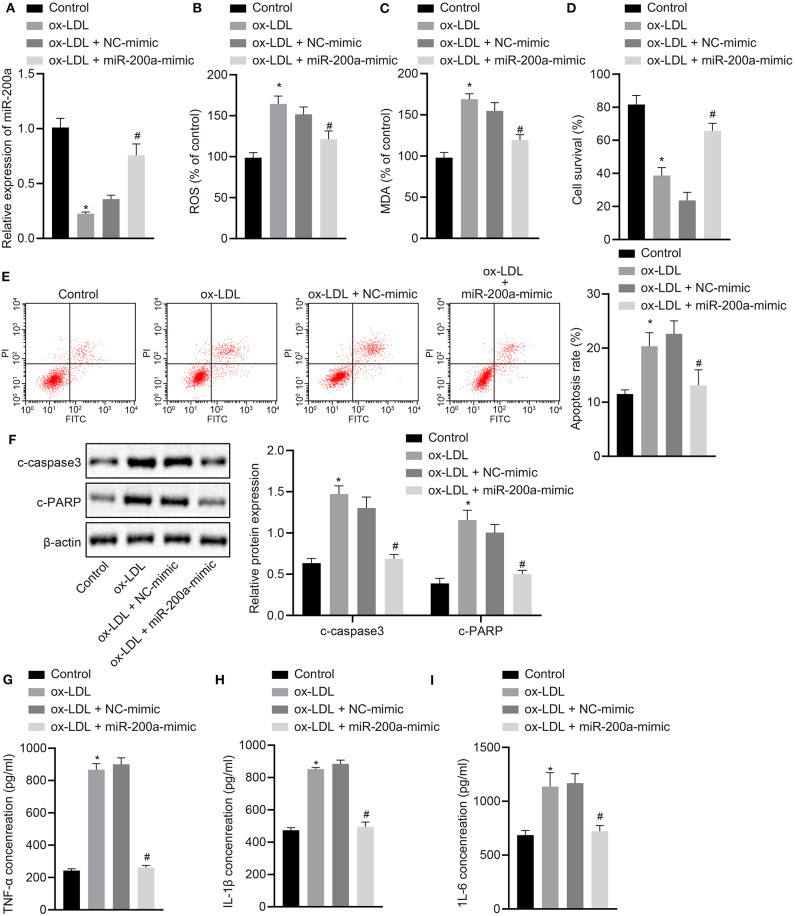
MiRNA-200a protects HUVECs against ox-LDL-induced apoptosis and inflammation. HUVECs were cultured with ox-LDL or treated with exogenous miR-200a mimic (with NC mimic as control). (A) miR-200a expression level in HUVECs determined using RT-qPCR, normalized to U6. (B) ROS level in HUVECs measured with ROS Assay Kit. (C) MDA level in HUVECs measured with ROS Assay Kit. (D) Cell viability of HUVECs detected by CCK-8 assay. (E) Apoptosis of HUVECs detected by flow cytometry. (F) Protein levels of cleaved-caspase3 and cleaved-PARP in HUVECs determined by Western blot analysis, normalized to β-actin. (G–I) Concentration of TNF-α, IL-1β, and IL-6 in the culture supernatants of HUVECs measured by ELISA. *(relative to untreated HUVECs) and #(relative to ox-LDL-treated HUVECs) indicate p < 0.05 by one-way ANOVA/Tukey's post-hoc test.